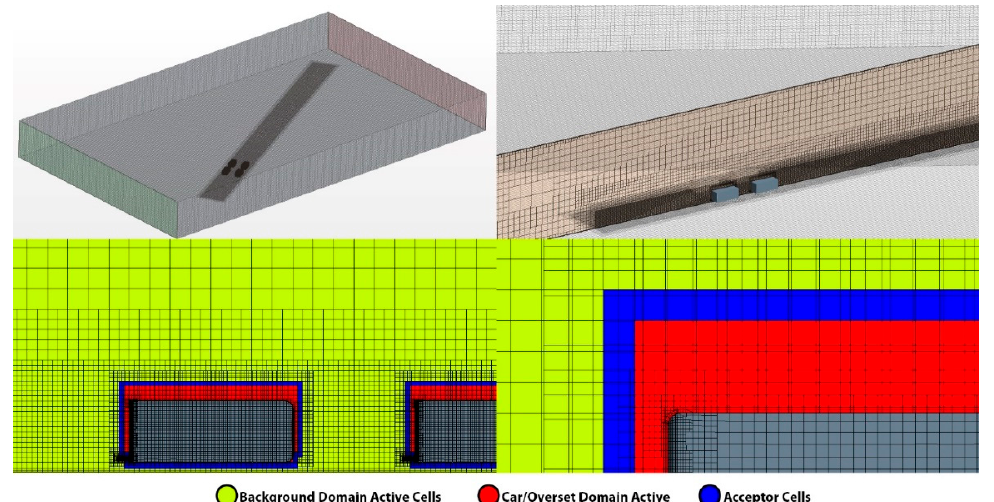
Figure 1. Hexahedral multiblock mesh together with Overset mesh configuration around the moving vehicles.